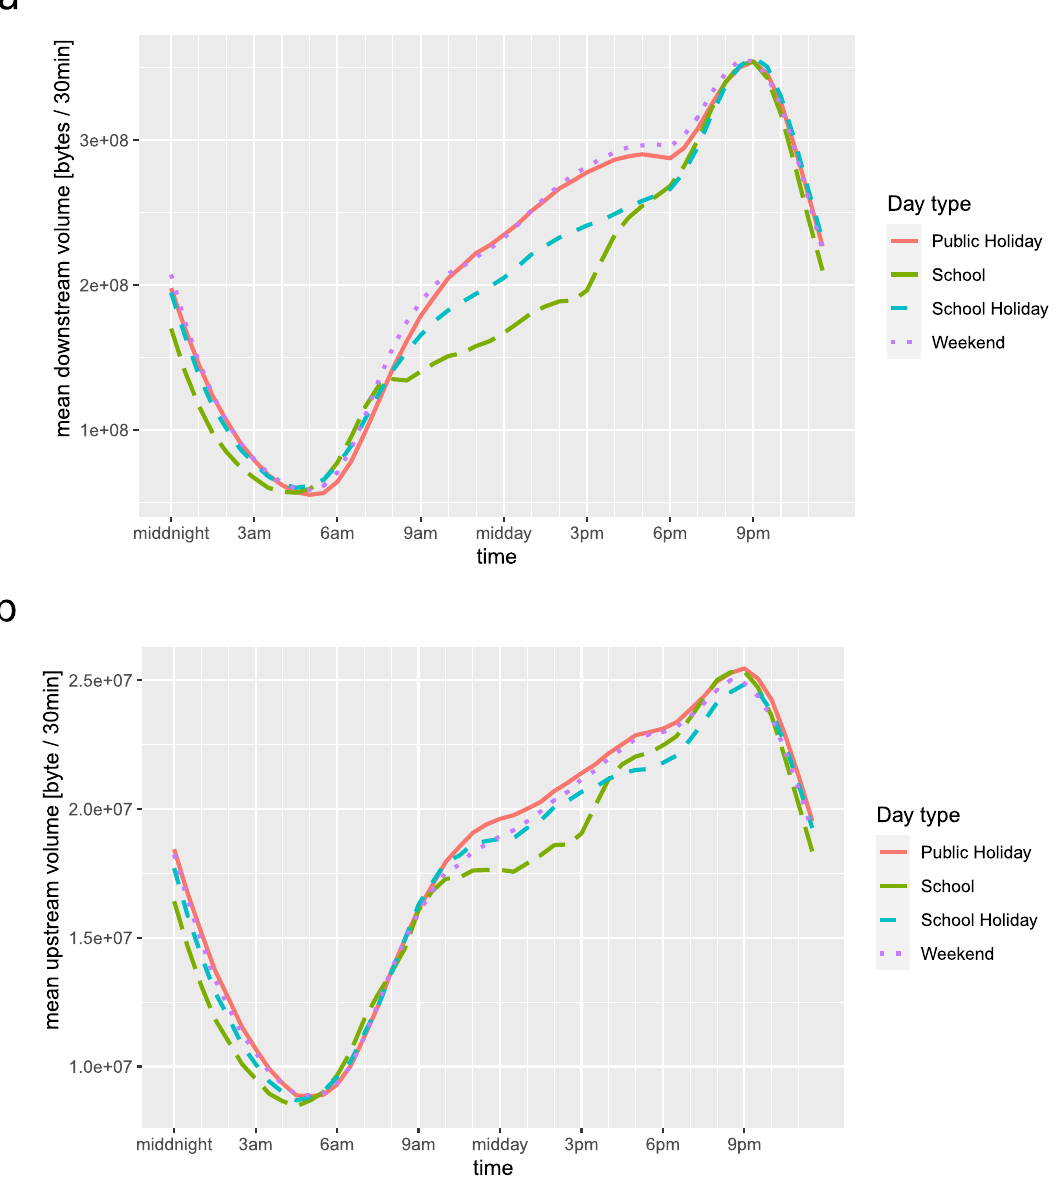
Figure 1. Long-term daily fluctuation of average internet activity per active service, per 30min period, for downloads ( a ), and uploads ( b ). The daily minimum and maximum, as well as the daytime plateau of activity are clearly visible. The changes between normal work days (school days), weekends and public holidays are salient. The daily trends in this figure were aggregated over the period from Sep. 1st 2019, to Sep. 1st